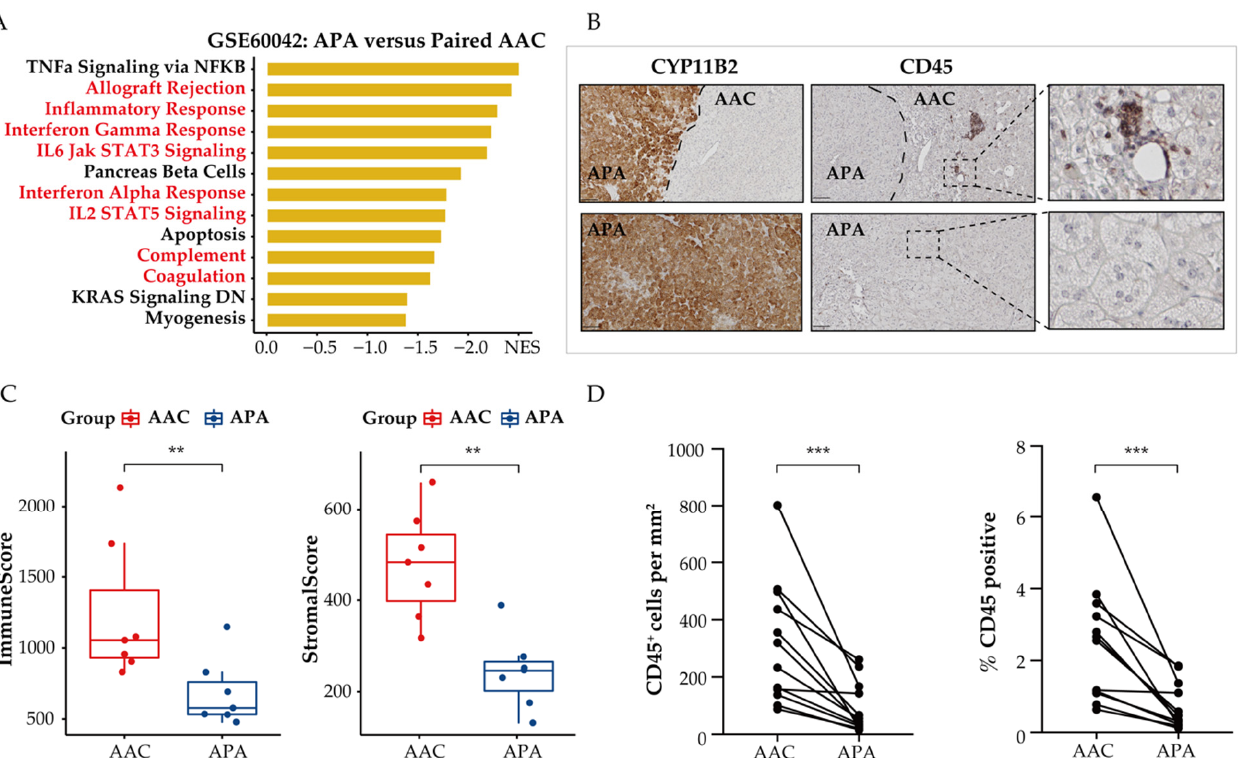
Figure 4. Spatial organization of tumor infiltrating immune cells in APAs versus paired adjacent adrenal cortex (AAC). ( A ) GSEA showing MSigDB hallmark of downregulated differentially expressed genes in APAs versus AAC (GSE60042). Pathways in red indicate functions related to immune response. ( B ) CYP11B2 and CD45 immunohistochemistry staining. The border of APA is defined by the CYP11B2 immunohistochemistry. Scare bar: 100 µ m. ( C ) ESTIMATE algorithm showing the distribution of ImmuneScore, StromalScore in APAs versus AAC. ** p < 0.01 by paired t test. ( D ) CD45 + immune cell density and positive percentage between APAs and AAC. *** p < 0.001 by paired Wilcox test. APA, aldosterone-producing adenoma; AAC, adjacent adrenal cortex; NES, normalized enrichment score.